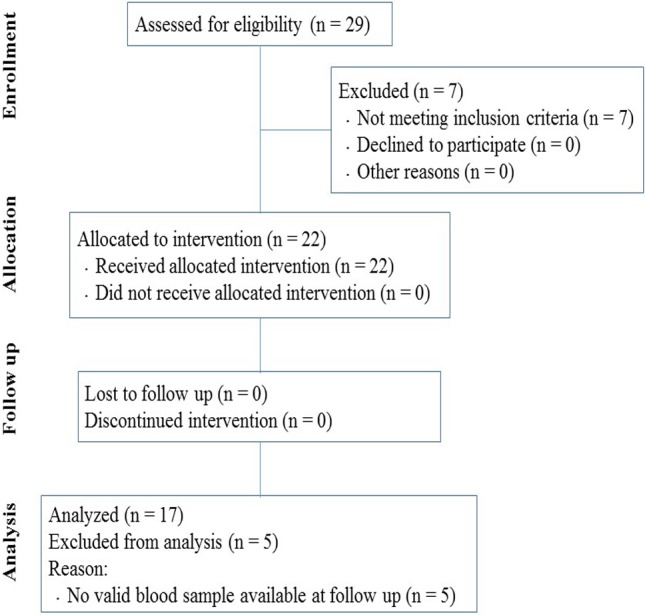
Flow diagram of participants through the study.